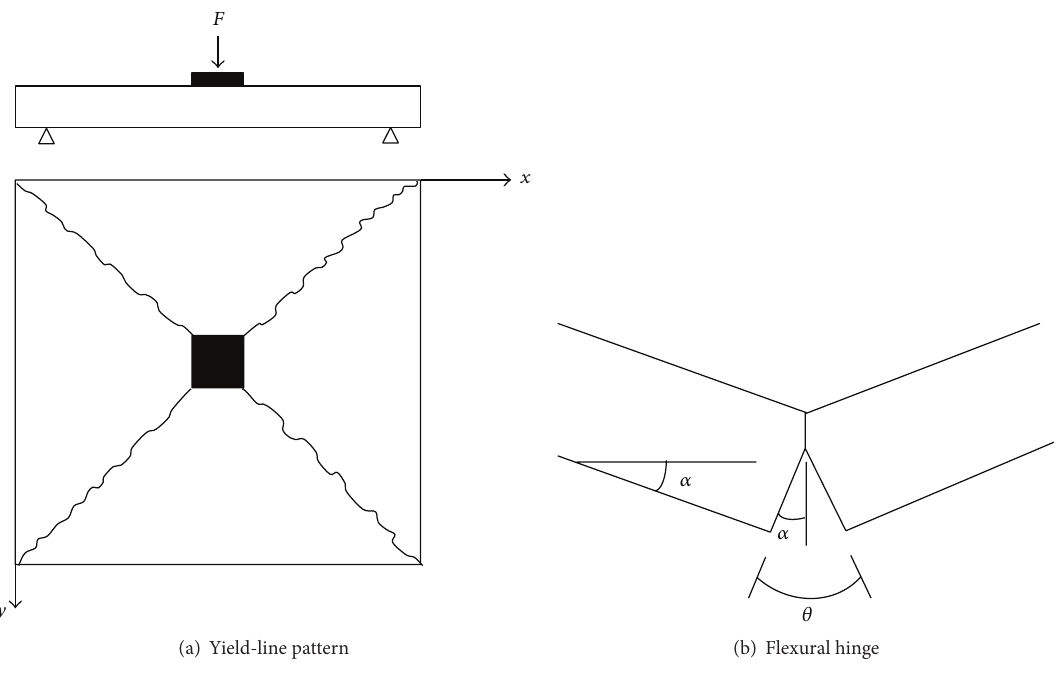
Figure 9: Analysis of the